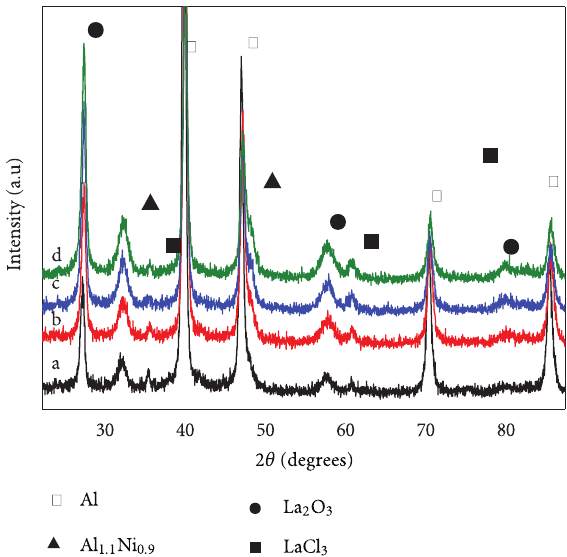
Figure 3: XRD results of Al- x wt% La-5wt% CoCl 2 mixture. x : a, 5; b , 10; c , 15; d ,